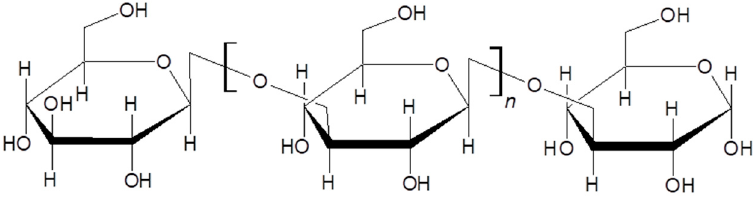
Figure 29. Curdlan chemical structure [161].